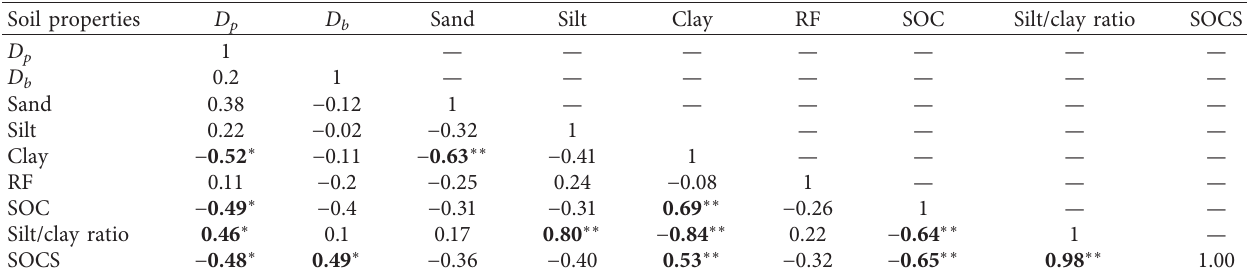
Table 5: Correlation amongst soil physical characteristics and soil organic